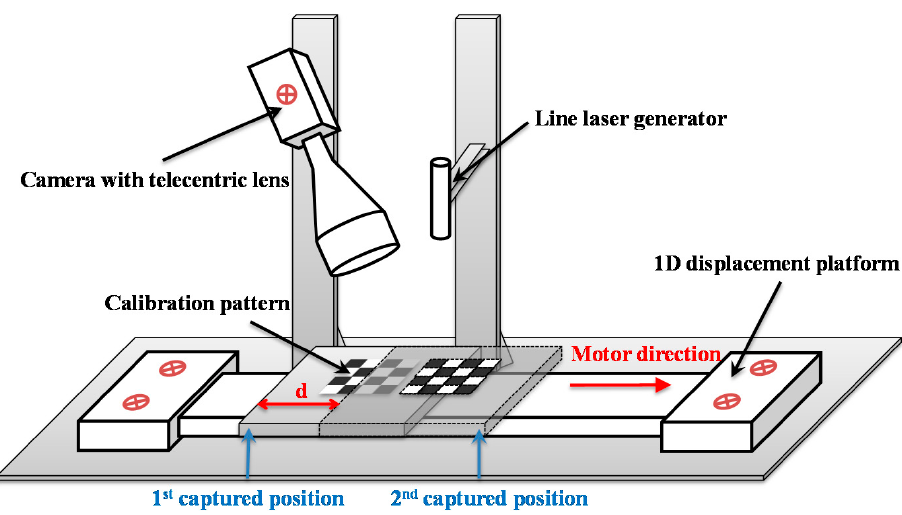
Figure 6. Motor directions calibrated in structure